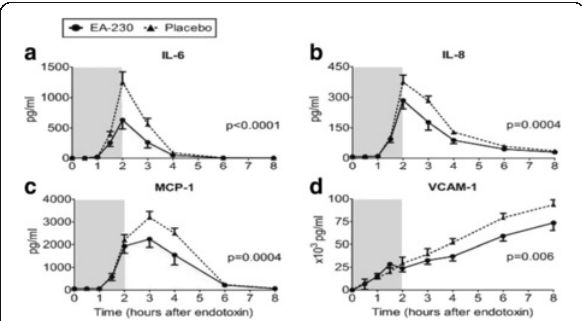
Fig. 50 (abstract A132). Plasma levels of inflammatory mediators and adhesion molecules during endotoxemia. (A) Interleukin-6, (B) Interleukin-8, (C) Monocyte Chemotactic Protein-1, (D) Vascular Cell Adhesion Molecule-1. Data are represented as means with SEM of n = 7 in the EA-230 180 mg/kg group and n = 12 in the placebo group. Gray box indicates the period in which the active group